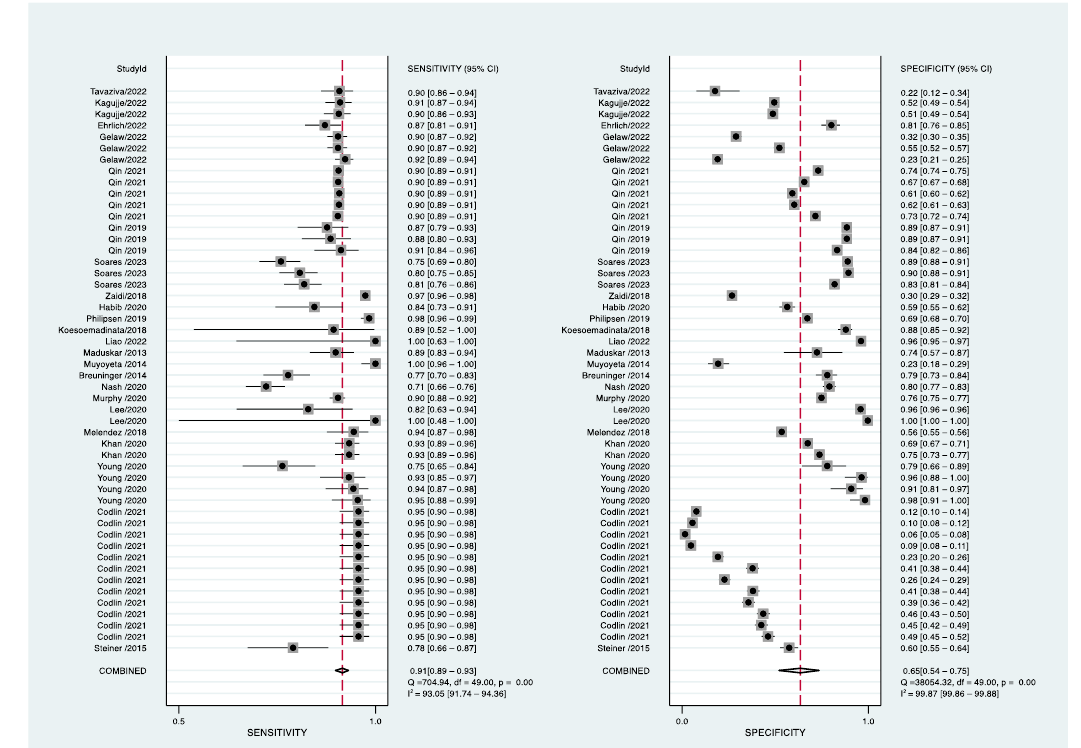
Figure 5. Forest plot of clinical-study sensitivity and specificity for PTB [6,12 – 33]. Table 2. Subgroup analysis based on different